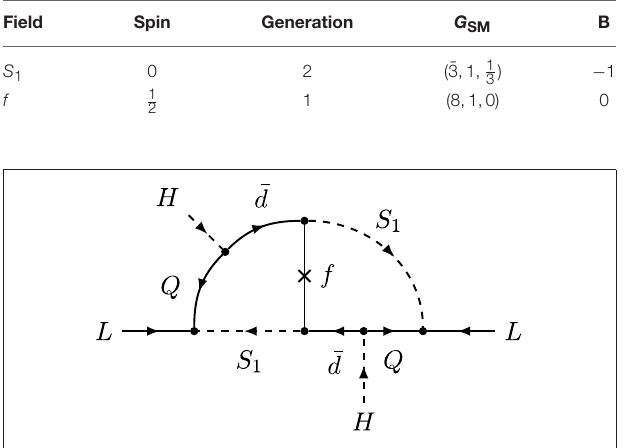
FIGURE 22 | 2-loop neutrino masses generated in the Angelic